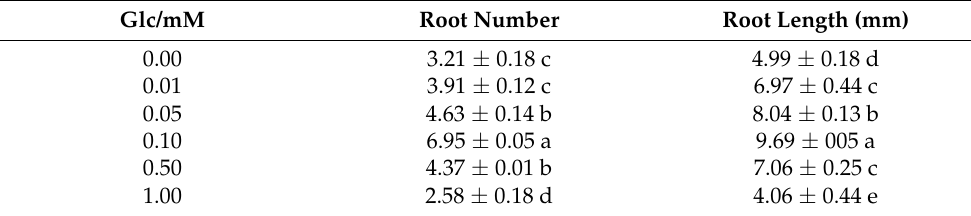
Table 1. Effect of Glc on AR development in